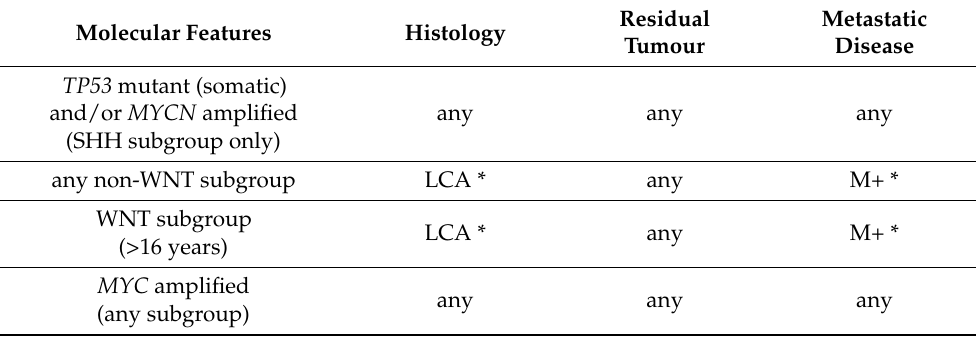
Table 1. Children older than 3 years at diagnosis are typically eligible for high-risk medulloblastoma trials based on current evidence. * Presence of at least one of these